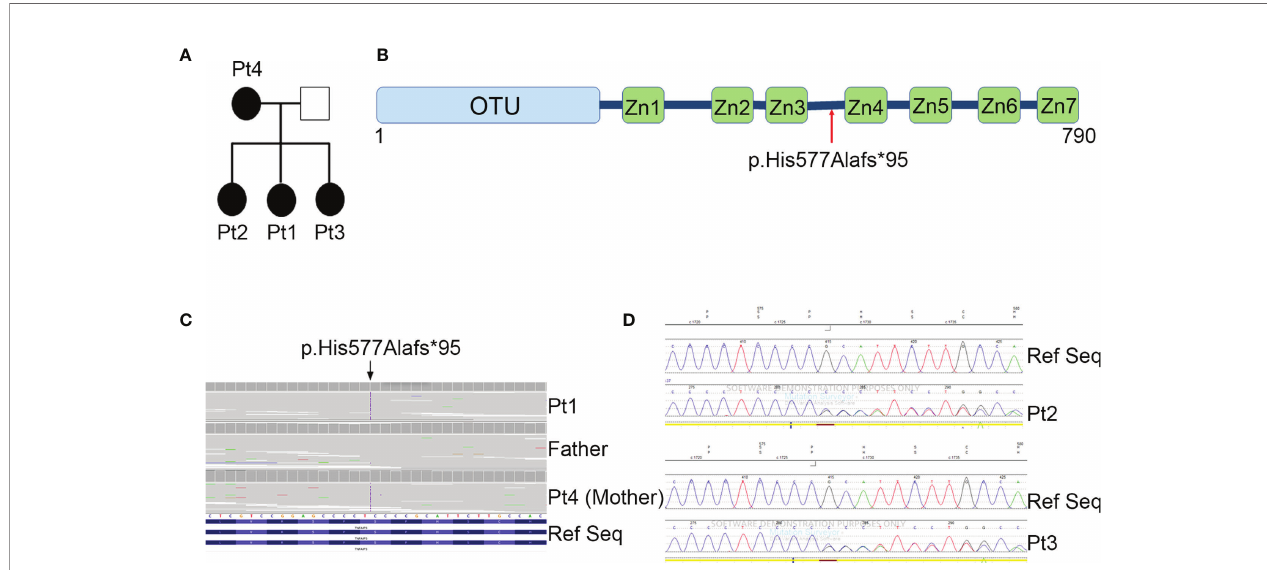
FIGURE 1 | Family pedigree and genetic analyses. (A) Pedigree of the family with the heterozygous mutation in TNFAIP3 gene. (B) Schematic diagram of A20 protein and the location of the new identi fi ed mutation. OTU, ovarian tumor domain; ZnF 1-7, zinc fi nger domains. (C) Whole exome sequencing identi fi ed a novel heterozygous mutation p.His577Alafs*95 in the TNFAIP3 gene. (D) Con fi rmation of the presence of the mutation in Pt2 and Pt3 by Sanger